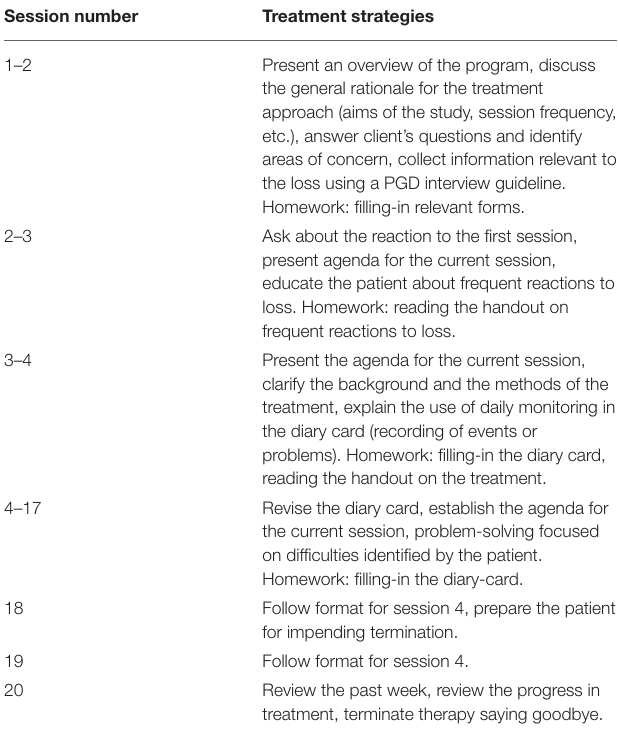
TABLE 1 | Treatment protocol of PCT adapted for